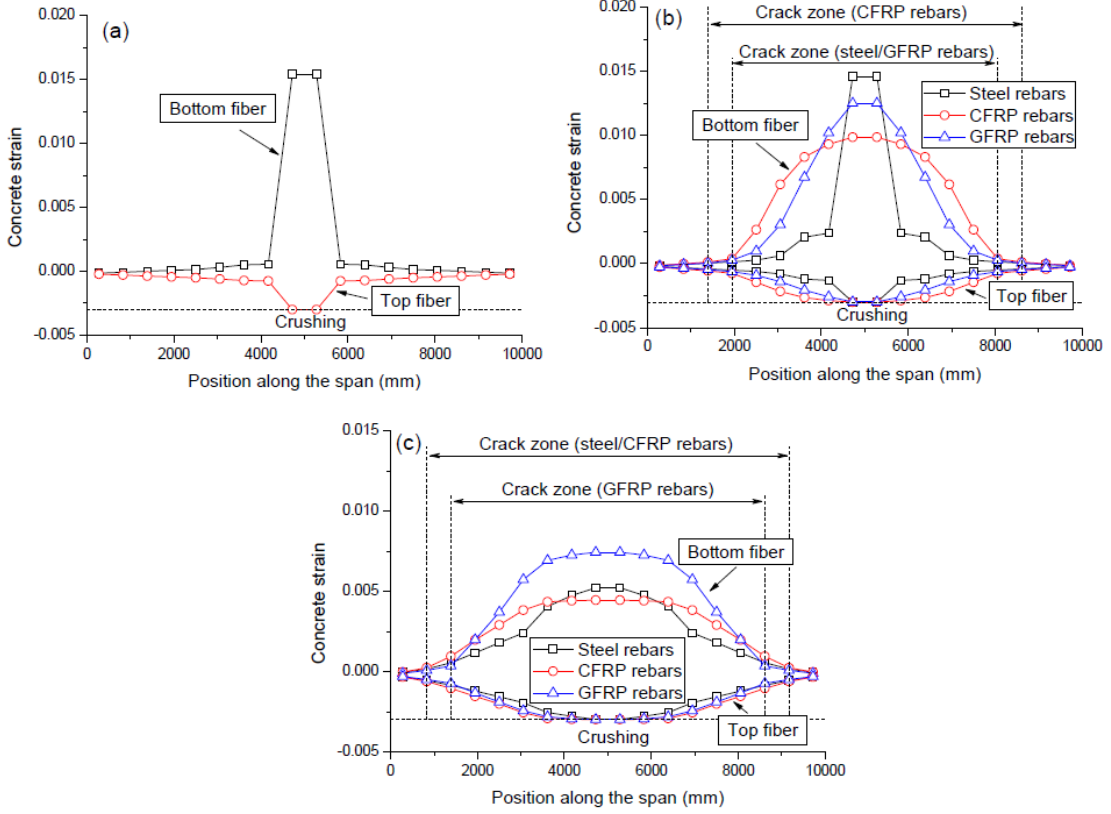
Figure 6. Concrete strain distribution at ultimate. ( a ) ρ r = 0.0%; ( b ) ρ r = 0.22%; ( c ) ρ r = 2.16%.